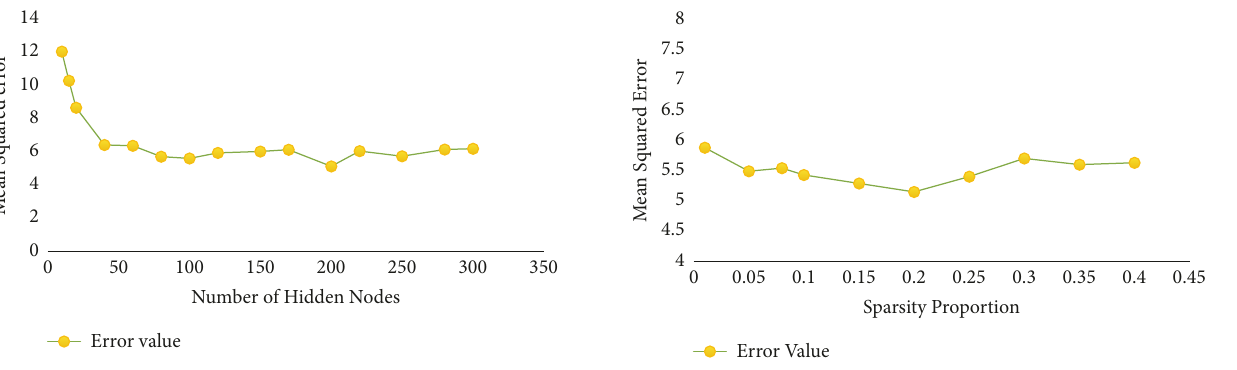
Figure 5: Effect of sparsity proportion on the reconstruction error.